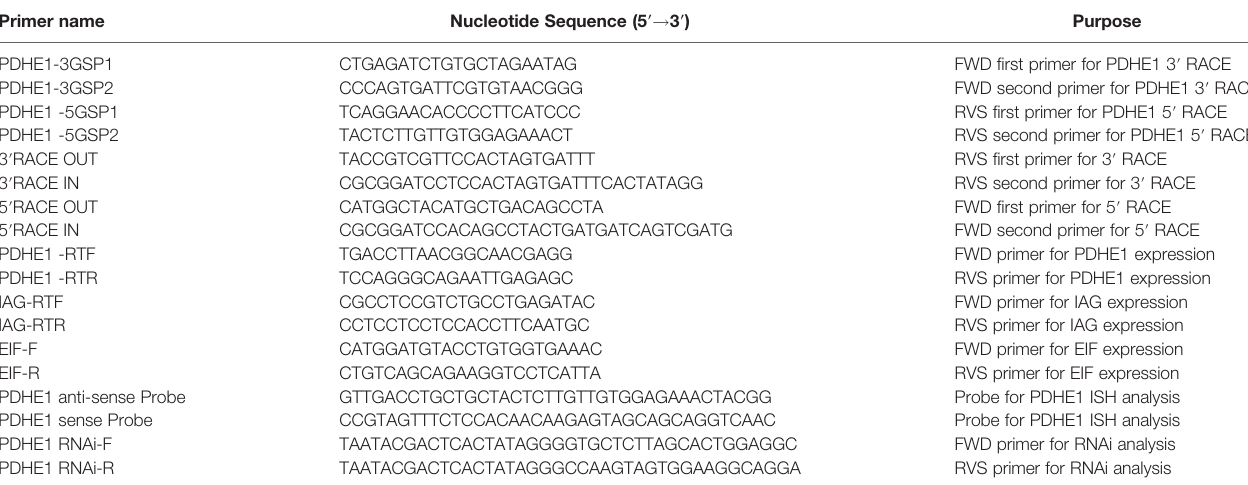
TABLE 1 | Universal and speci fi c primers used in this